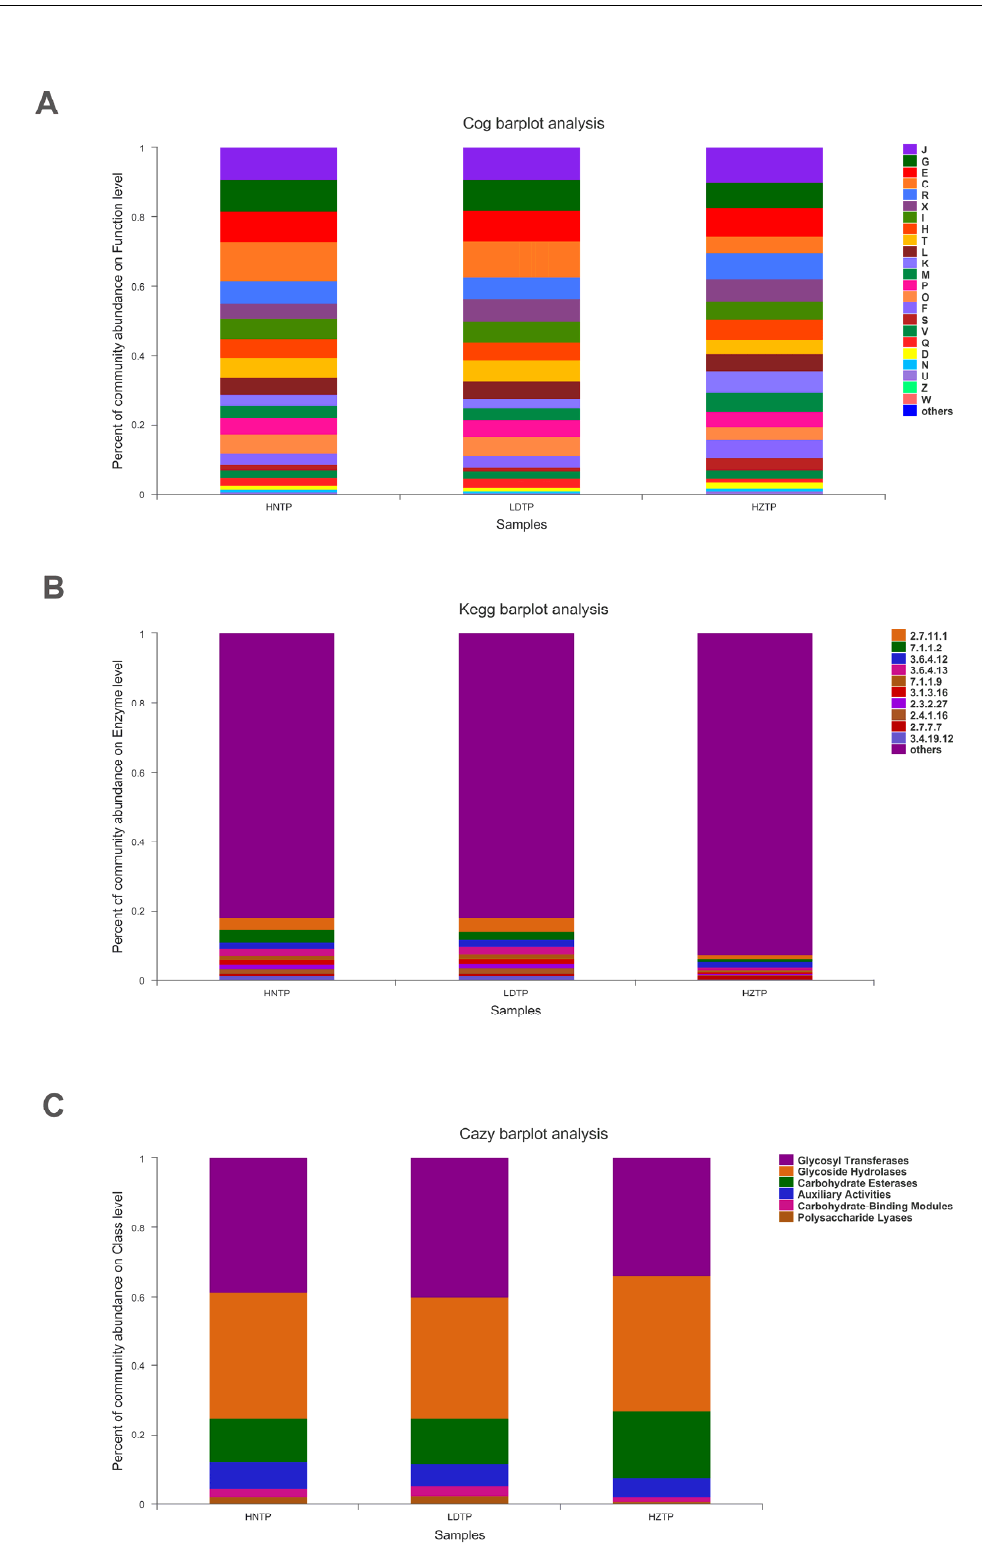
Figure 2. Microbial functional annotation and compositions of Tianpei samples. ( A ) COG analysis, ( B ) KEGG analysis-enzyme, and ( C ) CAZy